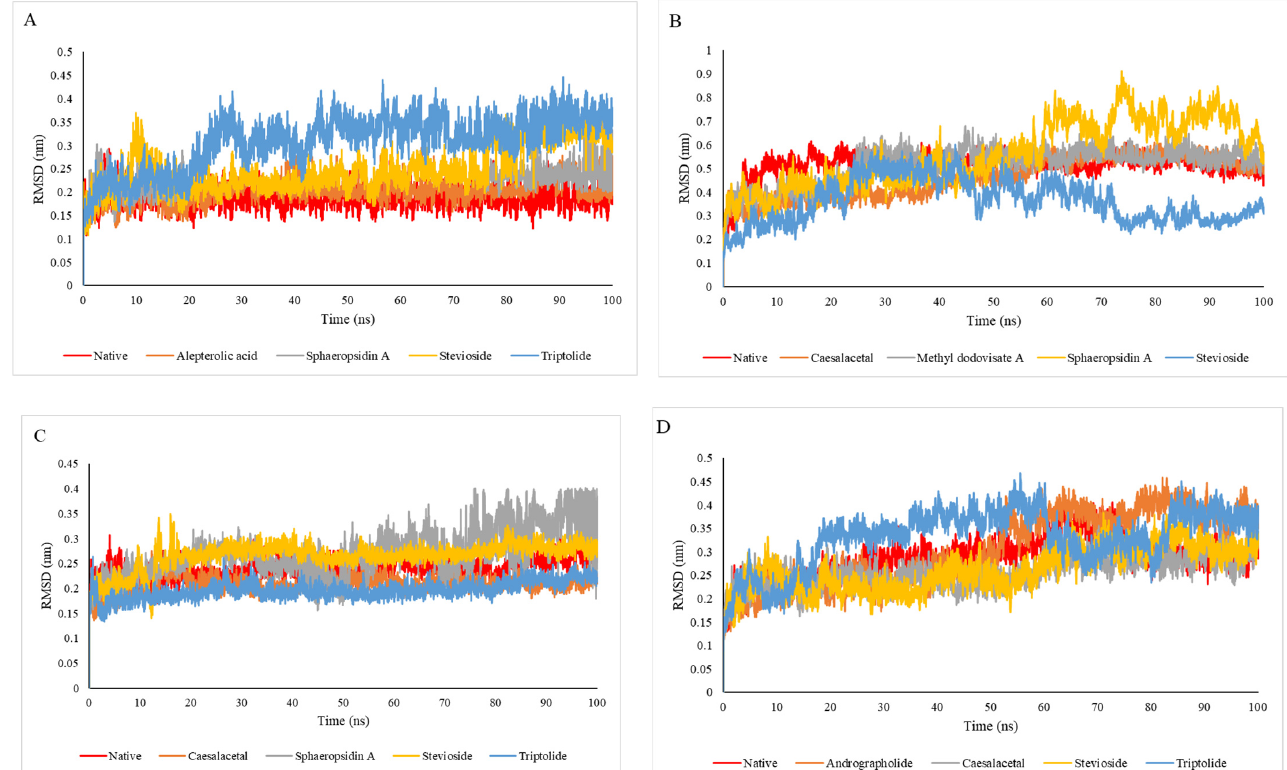
Figure 8. The RMSD plot for the backbone atoms for ( A ) 1OKE; ( B ) 2VBC; ( C ) 4O6B, and ( D )